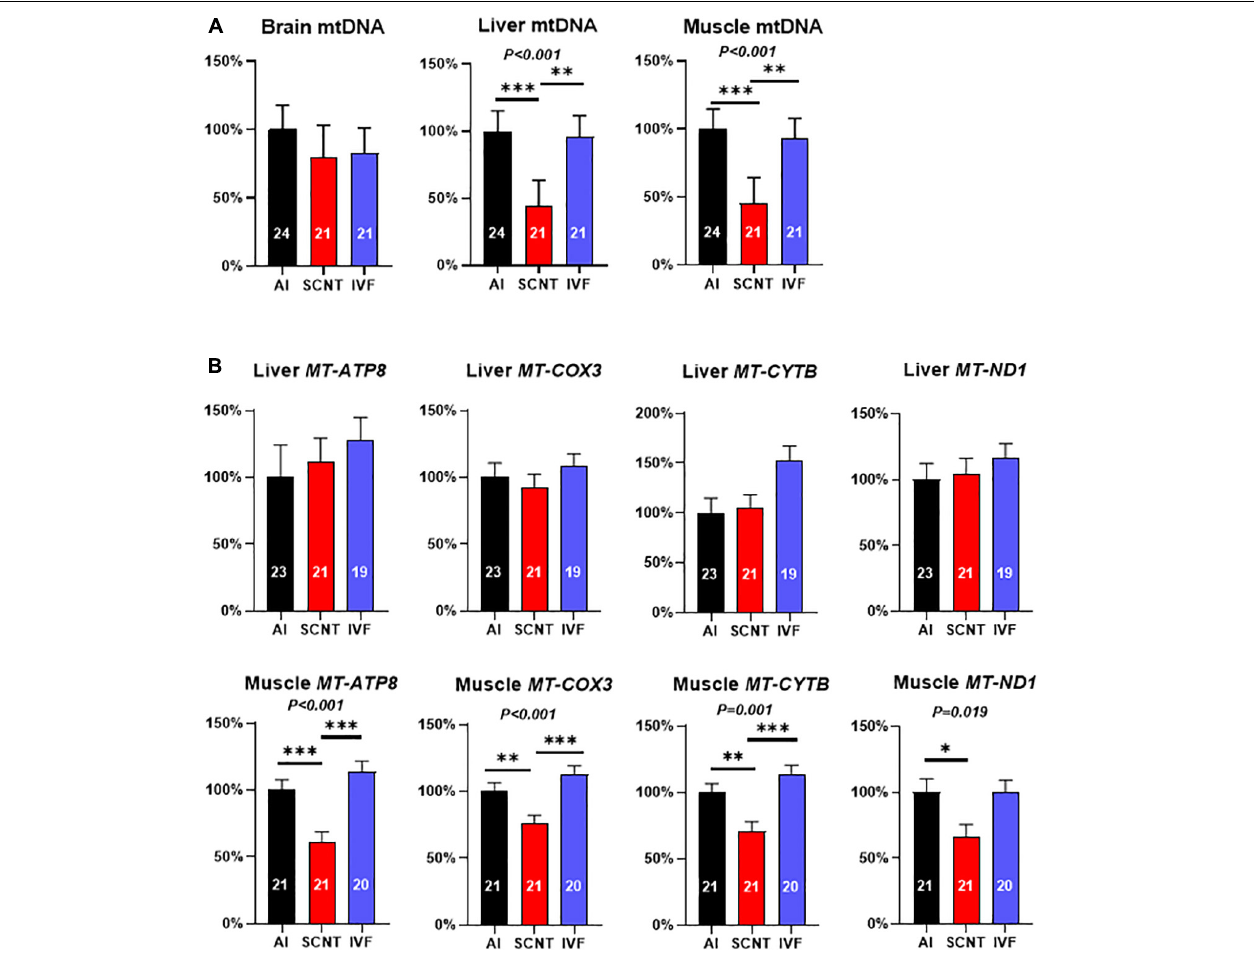
FIGURE 2 | Somatic cell nuclear transfer (SCNT) affects mitochondrial DNA (mtDNA) amount and mitochondrial gene expression. (A) Effects of SCNT on relative mtDNA amount of fetal tissues as compared with in vitro fertilization (IVF) and artificial insemination (AI) controls at day 80 of gestation. (B) Effects of SCNT